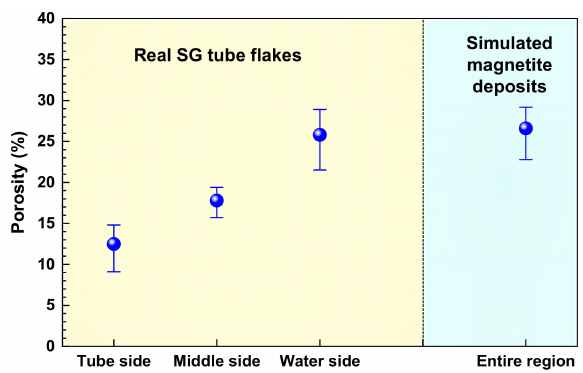
Figure 9. Porosity of the simulated deposit and real SG tube flakes.